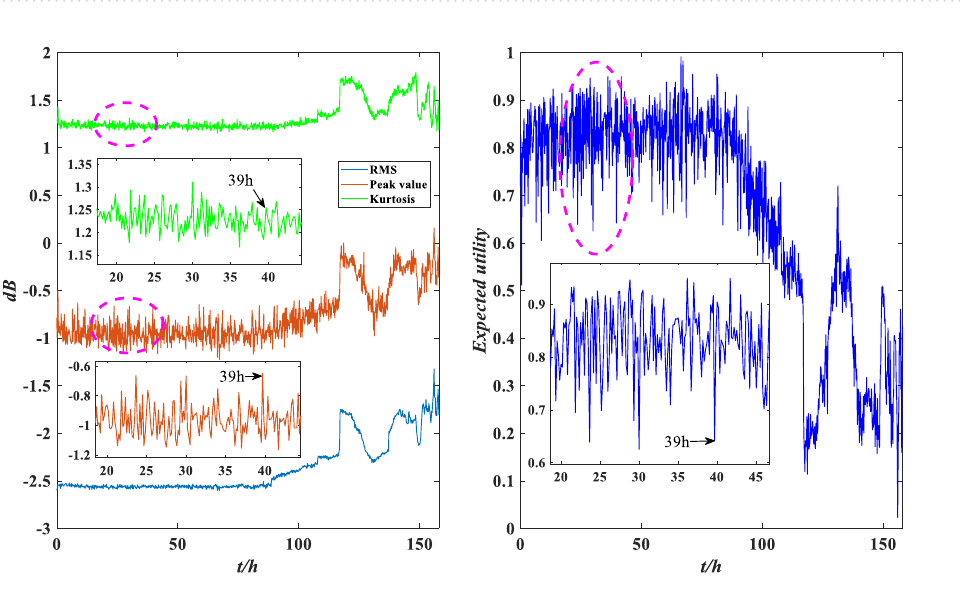
Figure 8. Local indicators and utility